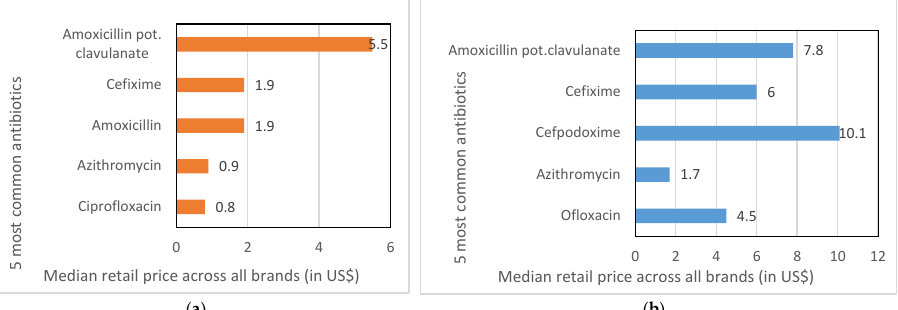
Figure 4. Median retail prices for standard courses of treatment across all available brands for the top five antibiotics stocked, by formulation. ( a ) Tablets ( b ) Syrups/suspensions/drops